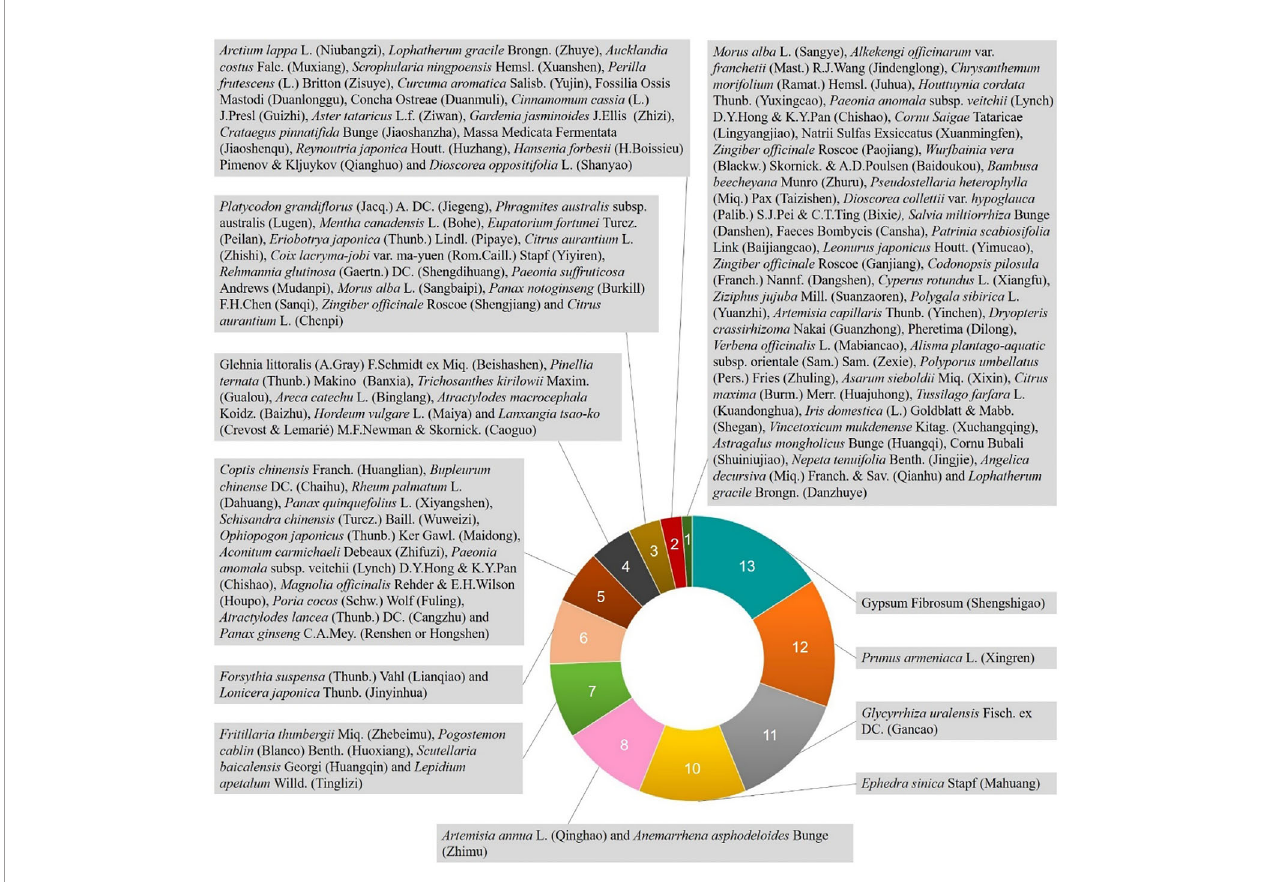
FIGURE 1 | Usage frequency of single herbal medicine in traditional Chinese medicine (TCM) part of the China National Guidelines of Diagnosis and Treatment for SARS-CoV, MERS-CoV, SARS-CoV-2, and in fl uenza virus (The statistical data were based on the analysis of each traditional Chinese herbal medicine involved in different syndromes of viral pneumonia in China ’ s National Guidelines for TCM treatment of SARS-CoV, MERS-CoV, SARS-CoV-2, and in fl uenza